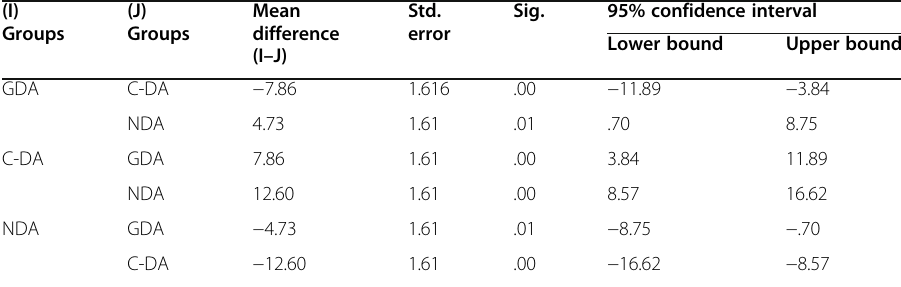
Table 8 Results of the Scheffe post hoc test for comparing GDA, C-DA, and N-DA mean scores on the speaking fluency post-test